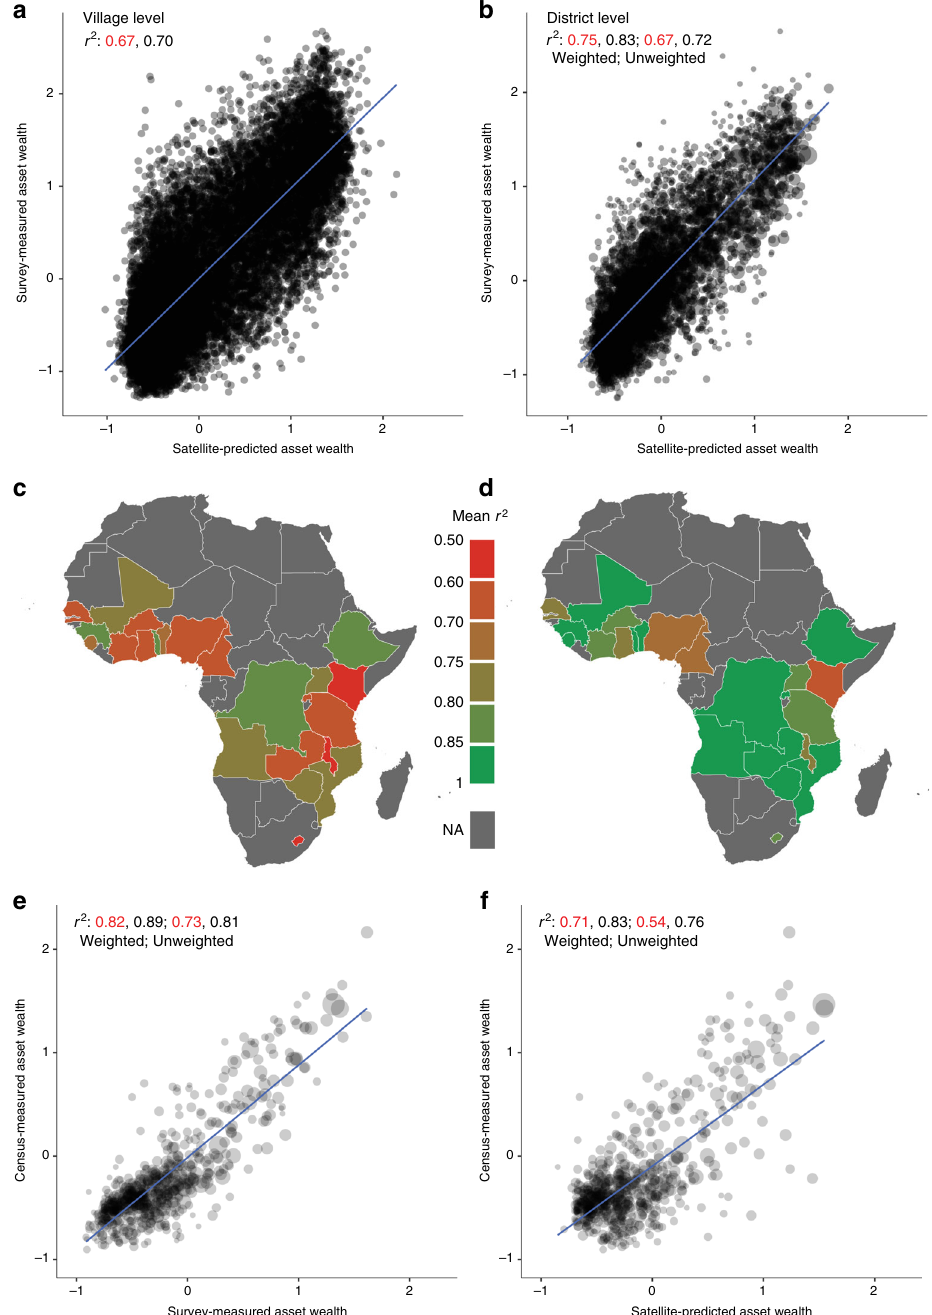
Fig. 2 Satellite-based predictions explain the majority of variation in survey-based wealth estimates in all countries, and validate well against independent ground measures. a Predicted wealth index versus DHS survey-measured wealth index across all locations and survey years; each point is a survey enumeration area (roughly, village) in a given survey-year, with satellite predictions generated by the CNN MS + NL model for each country from a model trained outside that country (predictions from 5-fold cross validation). r 2 values in red report goodness-of- fi t on pooled observations, whereas values in black are the average of r 2 calculated within country-years. b As for a , but indices aggregated to the district level. c Average r 2 over survey years at the village level, by country. d Average r 2 over survey years at the district level, by country. e Comparison of DHS-based to independent census-based asset wealth at the district level, for available census measures within 4 years of DHS survey. f Comparison of asset wealth predicted by the CNN MS + NL model in held-out-countries to the independent census-based asset measures at the district level. In b , e , and f , r 2 is reported both weighted and unweighted by the number of villages contributing to each district-level average. The number of villages is represented by the dot